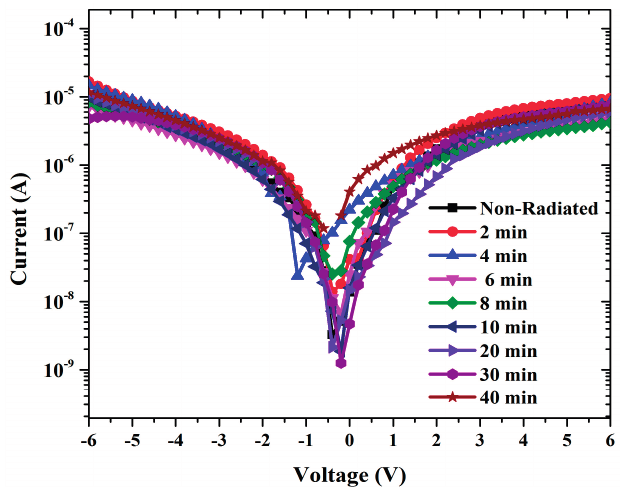
Figure 3. Curves show the I-V characteristics of Al/DNA/p-Si Schottky diode at room